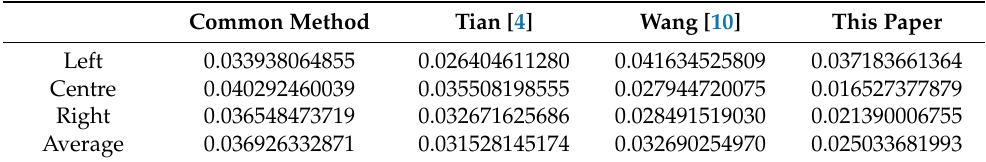
Table 1. Mean value of image residual